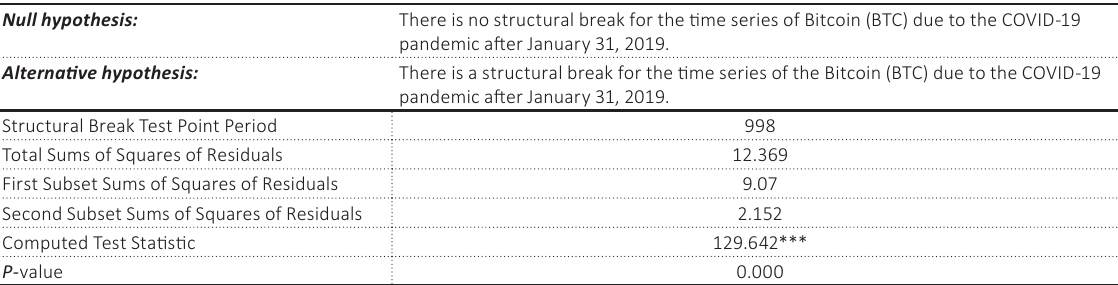
Table 4. Breusch–Godfrey Lagrange multiplier tests for serial